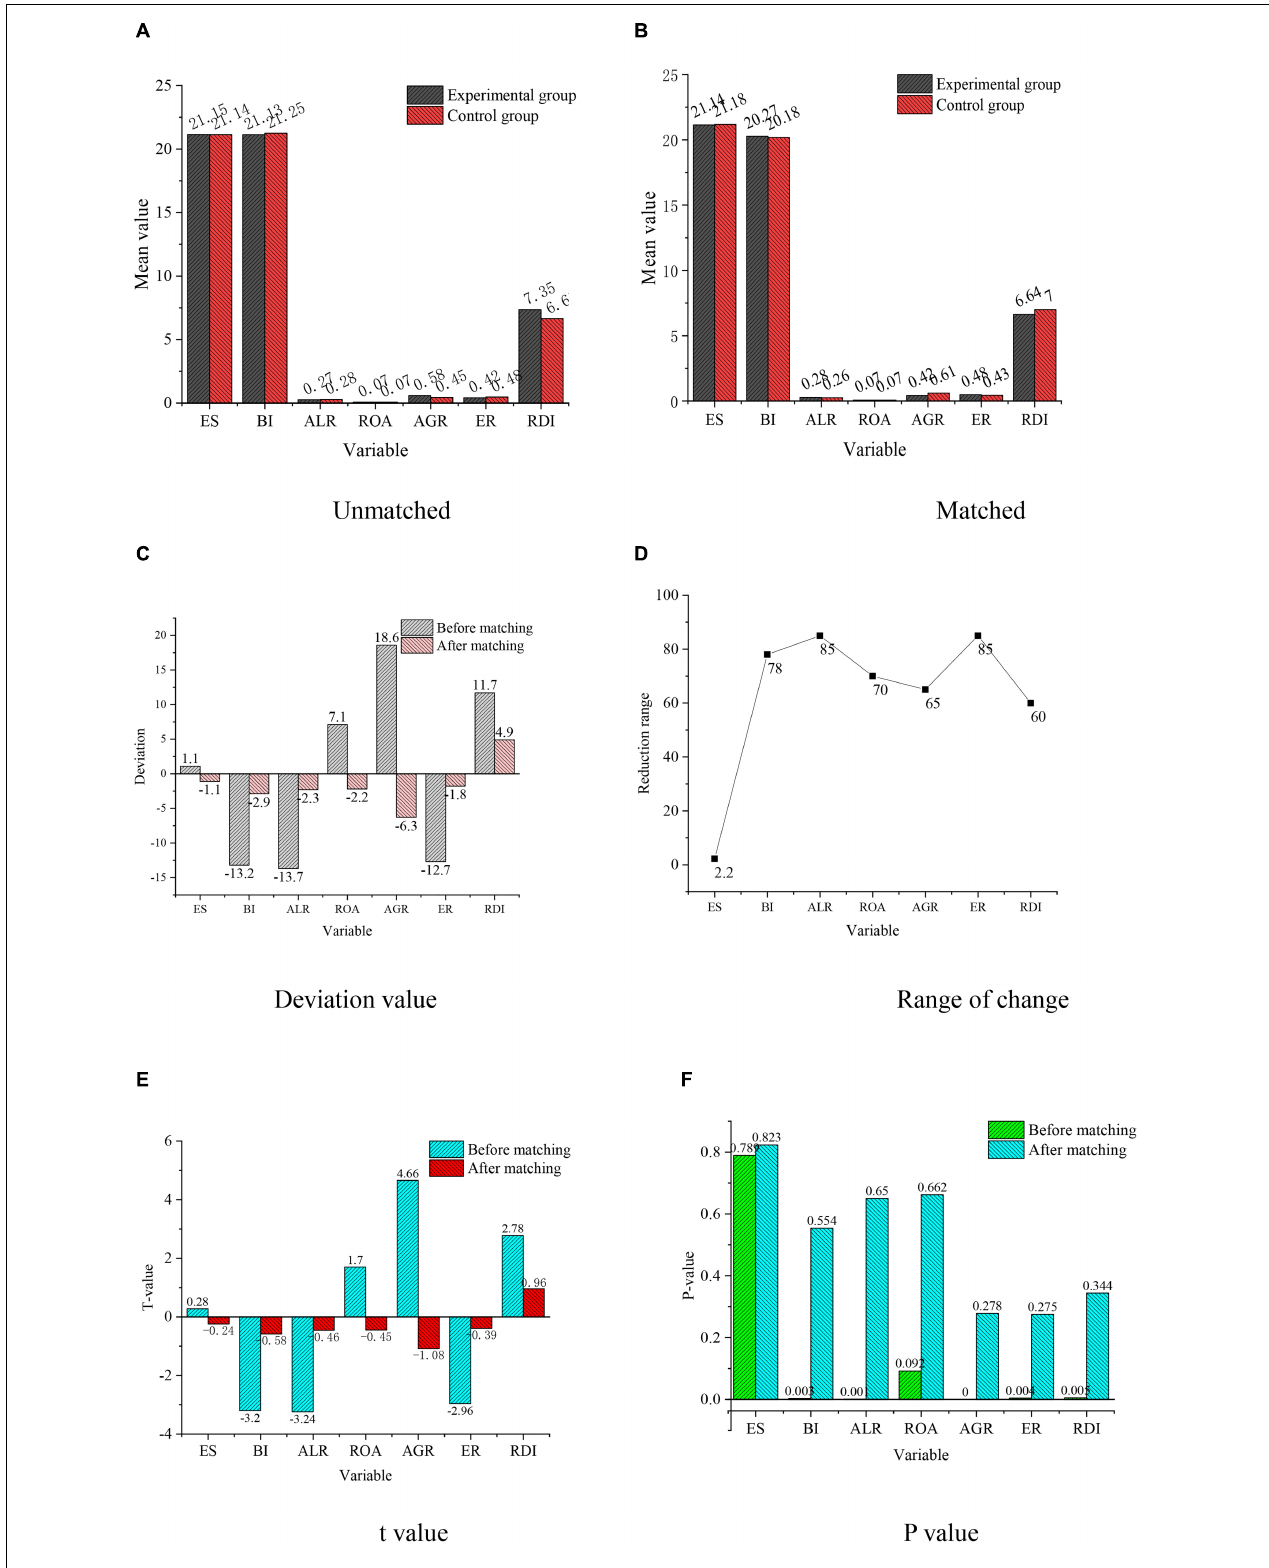
FIGURE 4 | Test results of variable equilibrium. (A) Unmatched. (B) Matched. (C) Deviation value. (D) Range of change. (E) t value. (F) P value.